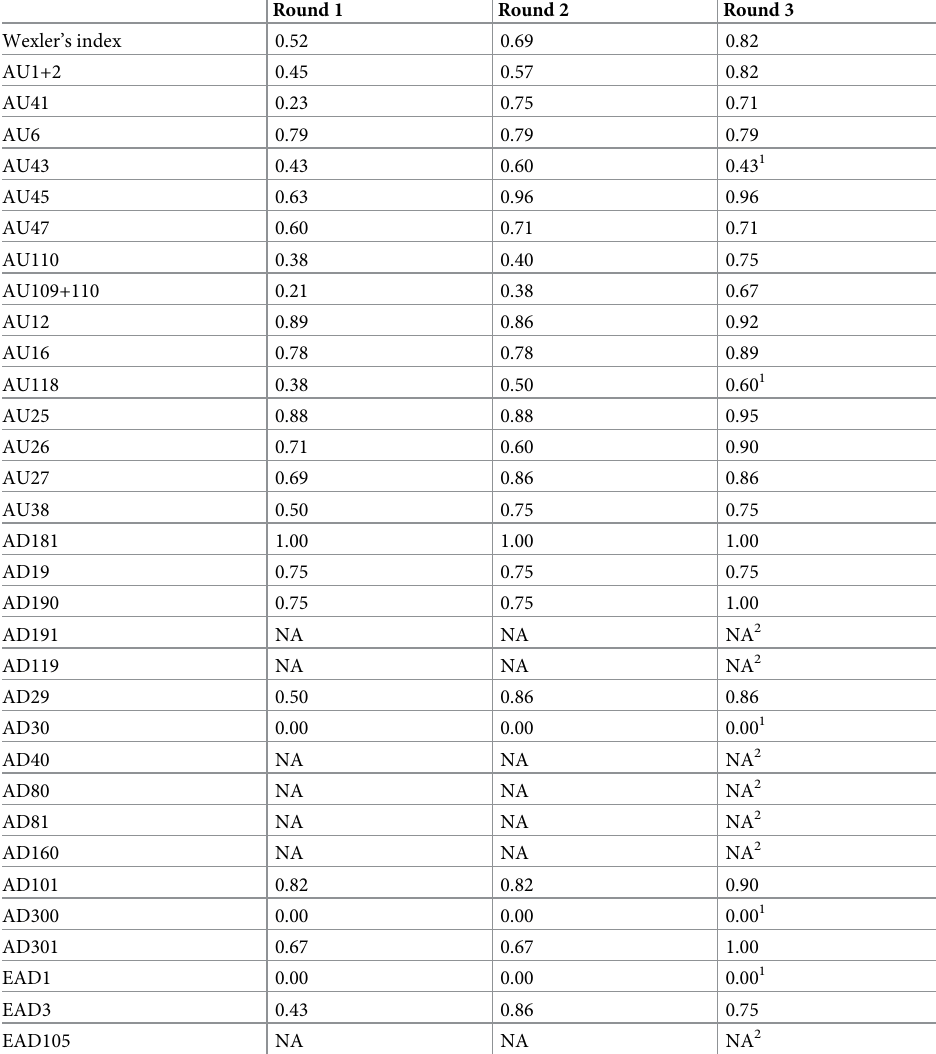
(DAW and AA) were blind to each other’s scores and to the third coder (CCC) scores. The coders’ overall reliability (Wexler’s index [67], Eq (1)) and the AUs independent coding agreement (calculated through the average of each AU agreement) from a first round of coding ( Table 4 ) indicated a low overall agreement between coders of 52%. A second round of coding increased the overall reliability to 69% ( Table 4 ), although this was not yet considered a "good" agreement [4, 68]. In a third and final round of coding, we obtained a very good mean agree- ment of 82% (including 89%, 84% and 74% for each pair of coders) from the Wexler’s index [67] (1), and also a good independent coding agreement on most AUs ( Table 4 ). The “coding Table 4. Mean Wexler’s index [67] (1) and independent coding agreement for each AU, AD and EAD in the three coding rounds. NA denotes instances where all coders agreed that a particular Action was not present in any of the